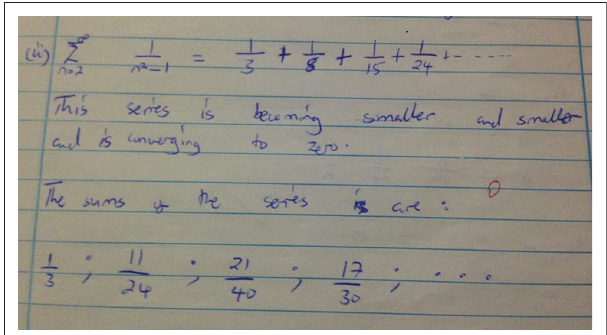
FIG URE 5: Written response of ST13 to task 1b